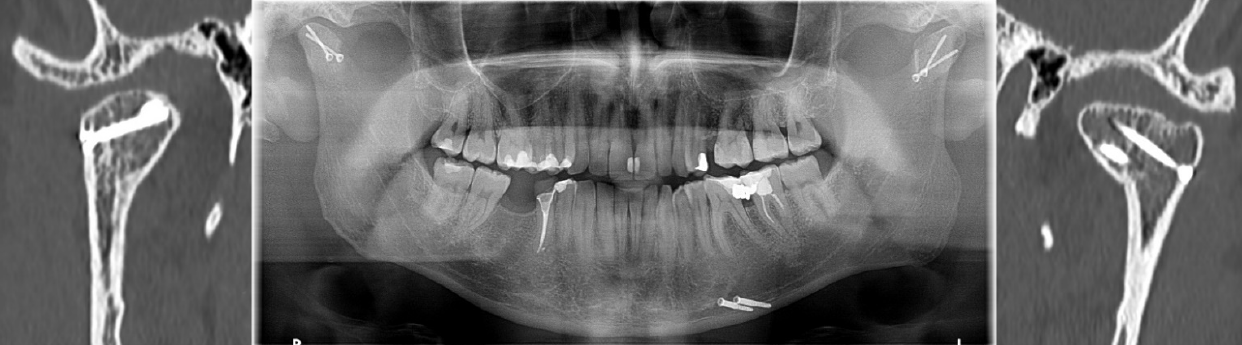
Figure 1. Radiological documentation showing the effect of surgical treatment of mandibular head fractures (examinations were acquired 12 months after osteosynthesis). A pantomogram radiograph is shown in the center as an overview study and CT coronal sections through the mandibular heads are shown on the sides. In the CT scan, the union and position of the headless compression screws can be accurately assessed (volumetric study makes it possible to obtain any cross-section). This patient had an additional fracture in the rim of the mandibular body on the left side. It was treated with lag-screws. Please note the small depression in the articular surface of the left mandibular head (CT image on the right side of this figure). It appears to be the result of a tiny shift between the fixated bone fragments. This shift, however, changes the height of the mandibular ramus.